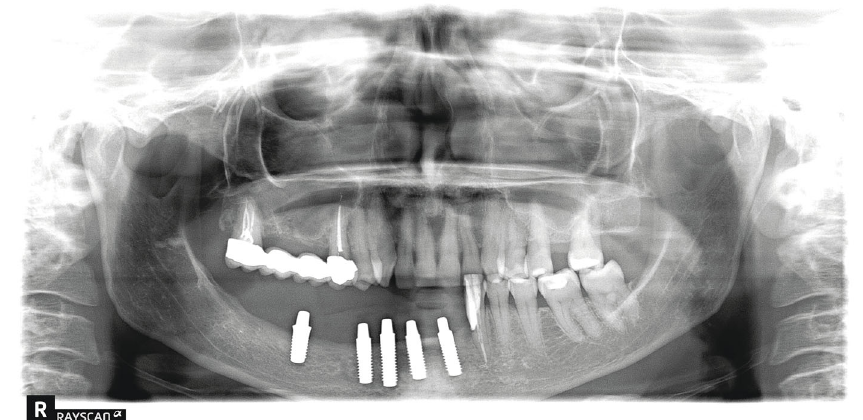
Figure 8: OPT after implant insertion.